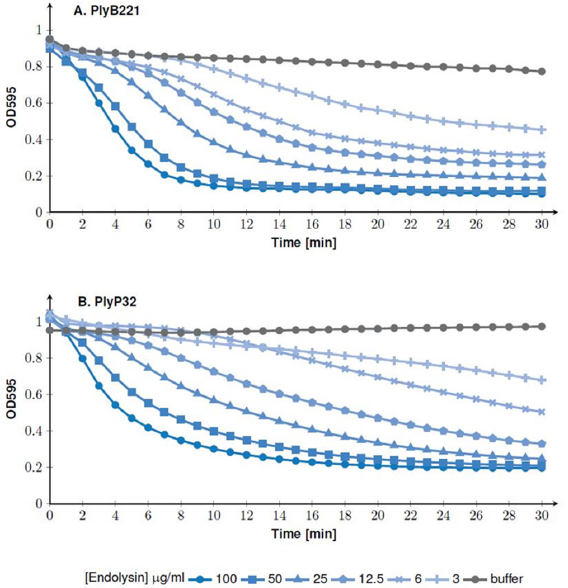
Figure 5. Bacteriolytic activity of PlyB221 ( A ) and PlyP32 ( B ) assessed by OD monitoring. The activity test was performed on exponentially growing B. cereus ATCC 10,987 at 30 °C in the optimal buffer for each endolysin and using enzyme concentrations ranging from 3 to 100 µg/mL.